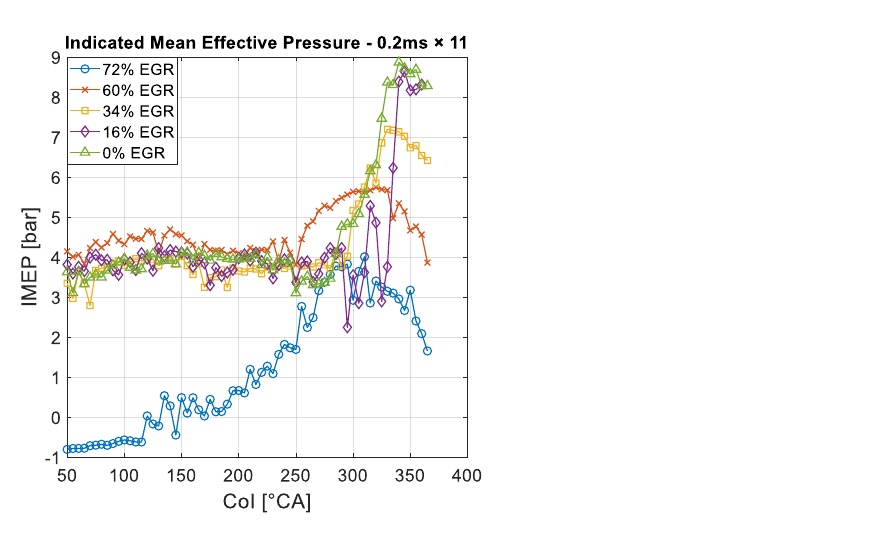
Figure 14. The IMEP of the 0.2 ms × 11 structure with different EGR rates in the function of CoI.